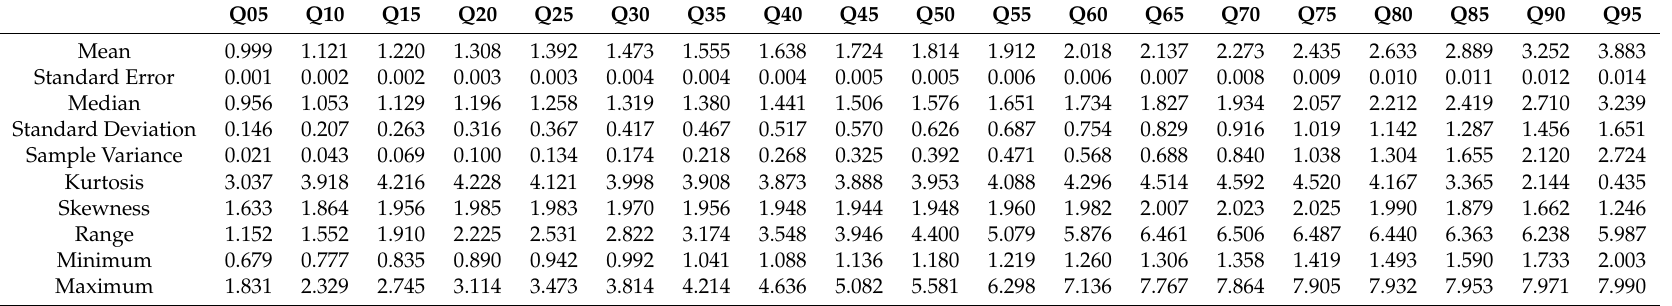
Table 5. Summary Statistics with Fitted values of Copula Quantile Regression.